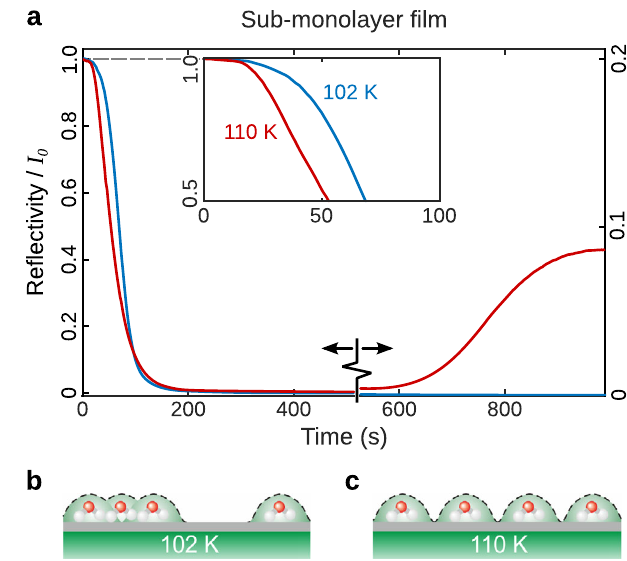
Fig. 3 Molecular adsorption in the sub-monolayer regime. a Helium re fl ectivity from a sub-monolayer fi lm, shown as a function of time during constant deposition of water molecules. The re fl ectivity is a measure of the fraction of the original, pristine surface that is exposed. At low coverages (time < 100 s), the intensity drops as individual water molecules obscure the underlying graphene. The blue curve shows adsorption at 102 K, a temperature where the morphology of thick fi lm measurements (Fig. 2) suggest the molecules are immobile on the time scale of the experiment. b Cartoon illustrating the random distribution of immobile H 2 O molecules (white and red spheres) on the graphene/Ni substrate in grey/green. The re fl ectivity falls rapidly due to the large scattering cross-section of each molecule (dotted lines) despite considerable overlap, even at a fraction of a monolayer. The re fl ectivity remains low as the thick fi lm, shown in Fig. 2b, is formed. The red curve in panel a shows the same rate of adsorption at 110 K, where the re fl ectivity drops even more quickly (time < 100 s). The faster drop is due to isolated water molecules obscuring a greater area of the graphene surface, as shown in c . We attribute the difference to an increased mobility compared to the curve at 102 K, allowing the molecules to achieve a lower energy con fi guration. It is the fi rst indication that repulsive interactions must keep the water molecules separated. At longer times and higher coverage (time > 600 s), the mobile molecules eventually nucleate ice structures, as discussed in the main text. The surface de-wets, allowing scattering from the underlying graphene to re-emerge, exactly as shown in Fig.